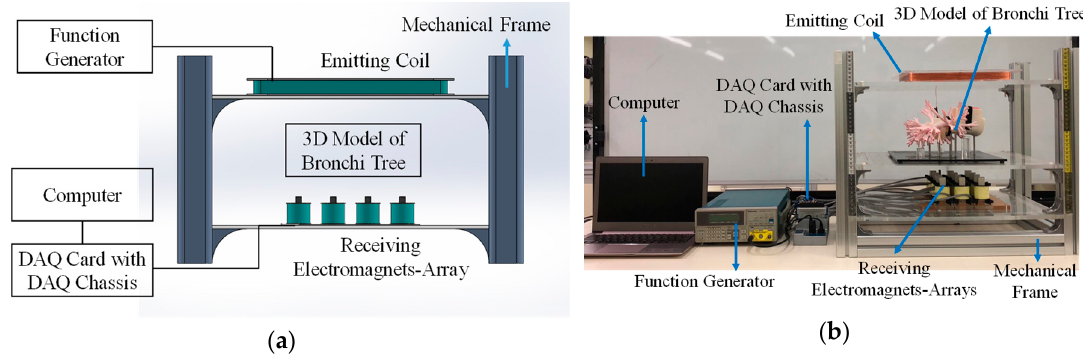
Figure 6. The targeting system after assembling: ( a ) the illustration and ( b ) the photograph of the system.